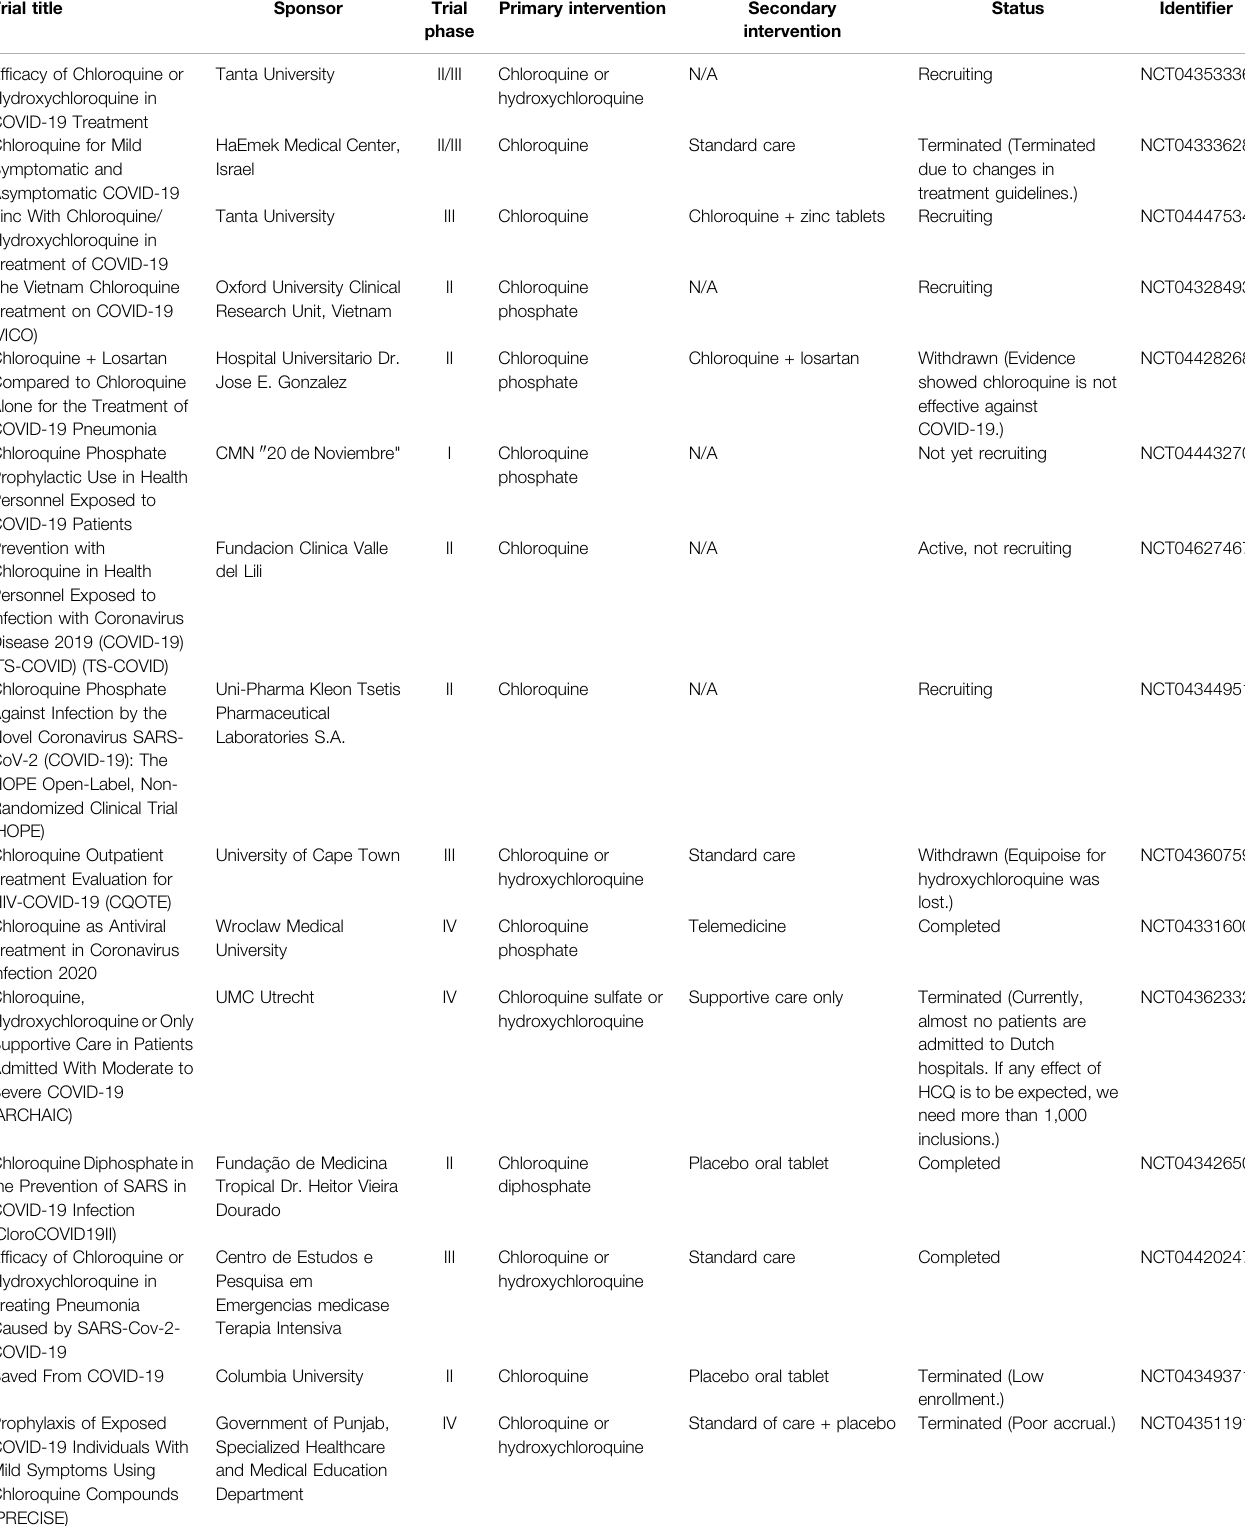
TABLE 1 | Summary of clinical trials of chloroquine (CQ) and hydroxychloroquine (HCQ) on COVID-19